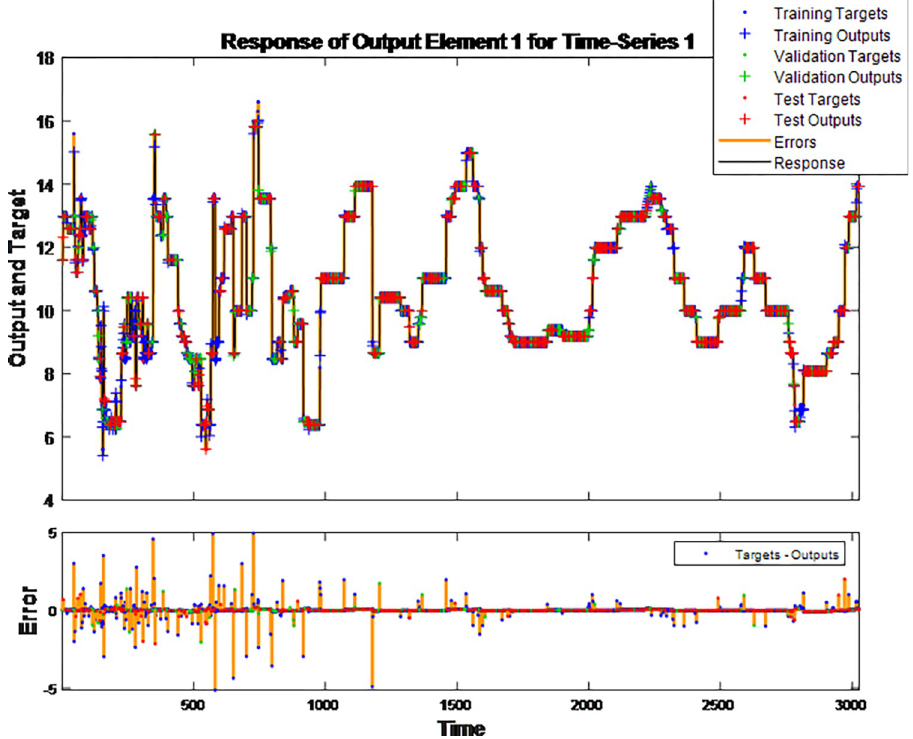
Fig 5. Long short-term memory training response plot.